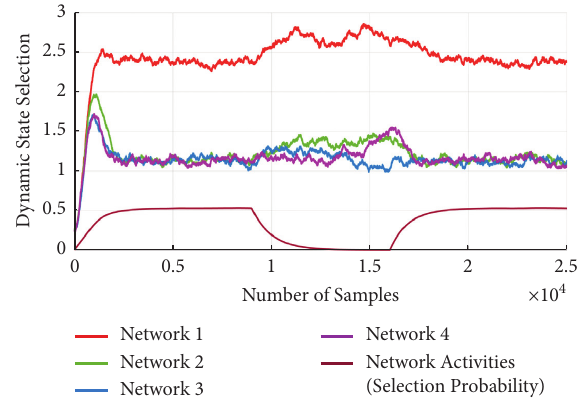
Figure 9: Effect of threshold on network connectivity for � 8 ) . sensitivity � 5 ( V thrl